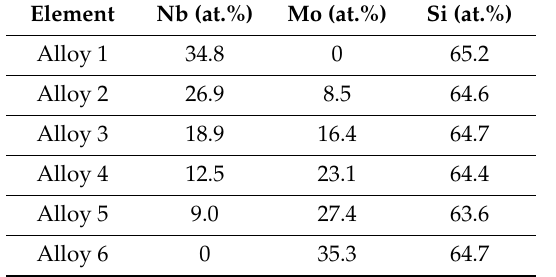
Table 2. EDS results of the (Nb x , Mo y )Si 2 coating layer of Si-pack-coated Nb x Mo y alloys (at.%).